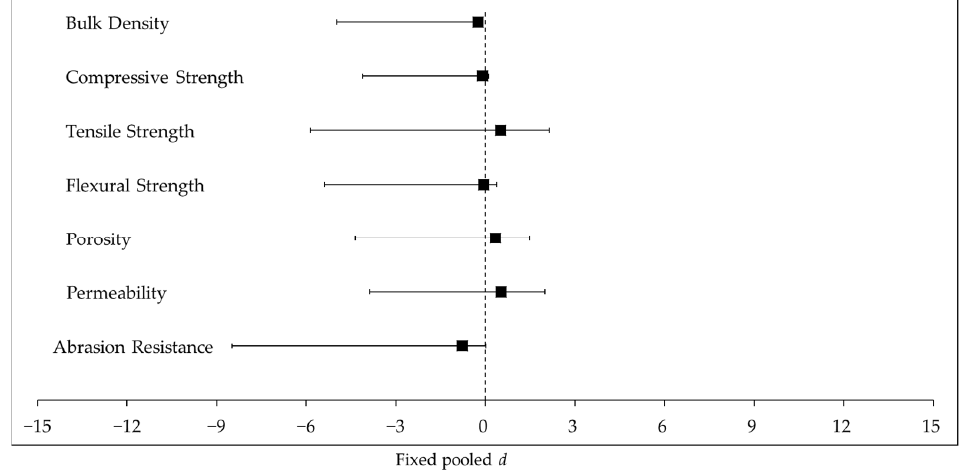
Figure 11. Overall performance of combined replacements based on fixed effect.